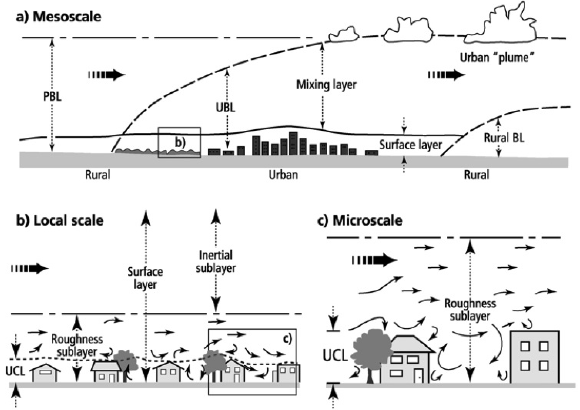
Figure 1: The vertical subdivision of the atmosphere along with the relevant urban climate scales, after Oke (2007) The presented work is part of the Climate City Campus